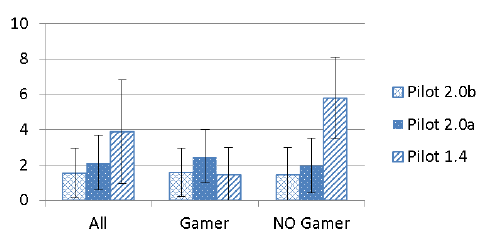
Figure 13. Following path